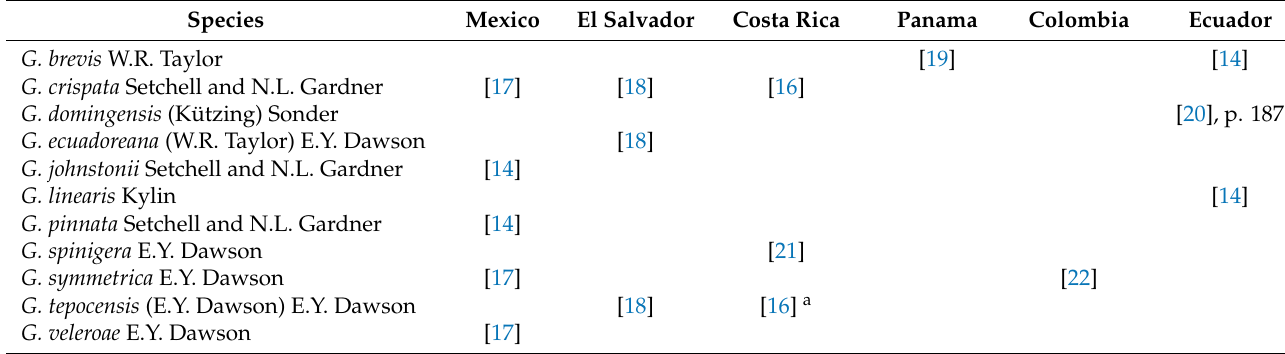
Table 1. Distribution of species of Gracilaria reported from the mainland coasts of tropical eastern Pacific countries. Reports from Guatemala and Nicaragua were not found. Numbers are reference citations.